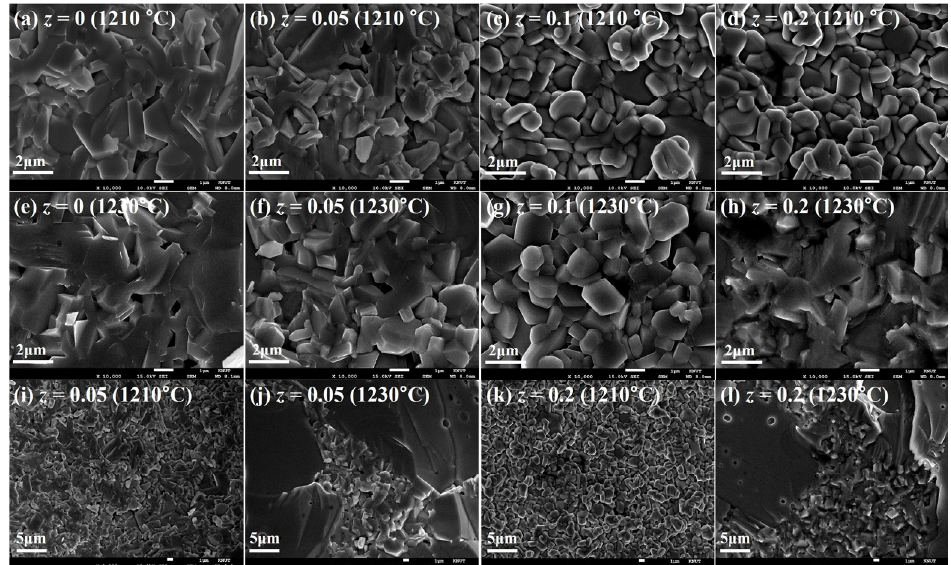
Figure 5. ( a – l ) SEM micrographs of Sr 0.4 Ca 0.3 La 0.3 Fe 10.2 Co 0.2 − z Mn z Si 0.05 Mg 0.05 O 19 ( y = 0, 1, 1.5, 2) samples sintered at 1210 °C and 1230 °C.